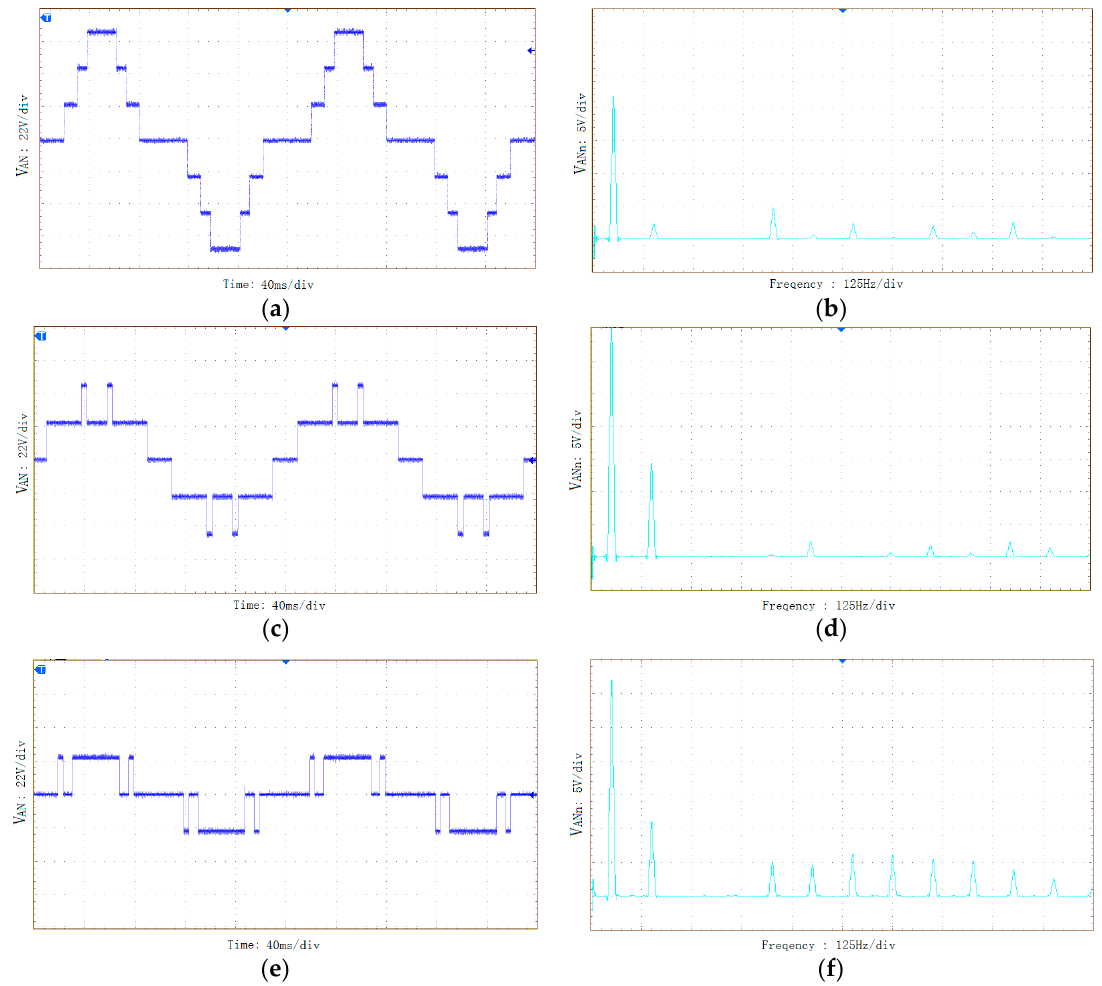
Figure 9. The phase voltage experiment waveforms and spectrums for A, B, and C patterns. ( a ) Phase voltage waveform for the A band. ( b ) Phase voltage spectrum for the A band. ( c ) Phase voltage waveform for the B band. ( d ) Phase voltage spectrum for the B band. ( e ) Phase voltage waveform for the C band. ( f ) Phase voltage spectrum for the C band.